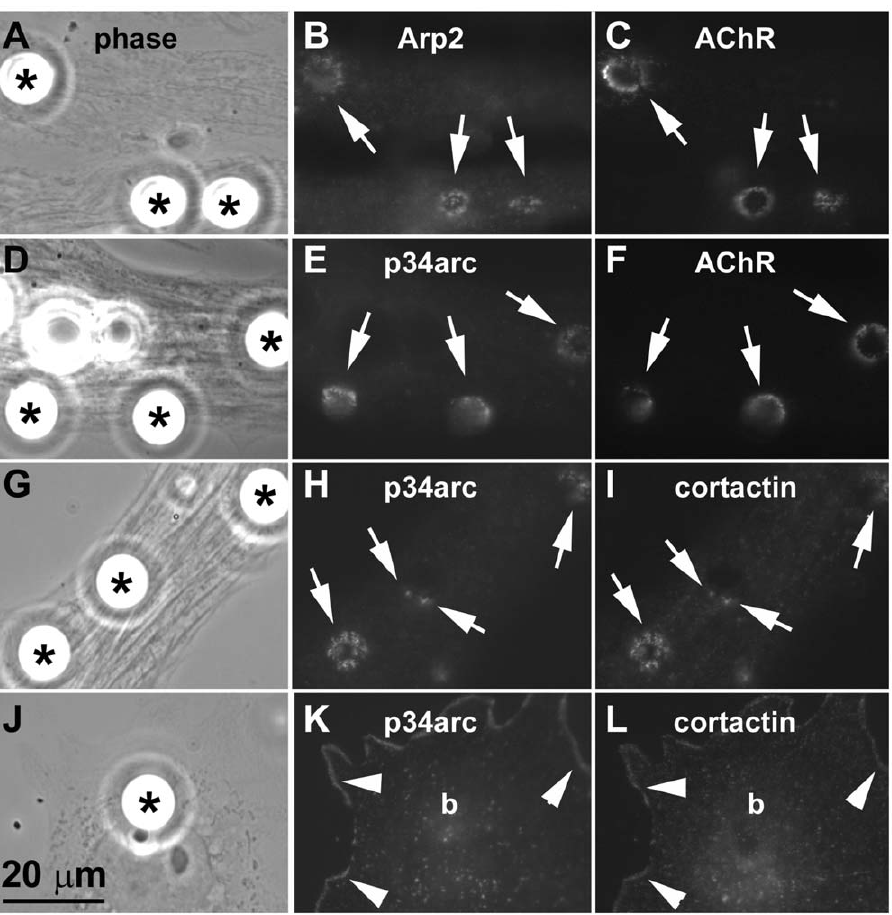
Figure 1. Localization of Arp2/3 complex proteins and cortactin at AChR clustering sites. Cultured embryonic Xenopus muscle cells labeled with rhodamine- a -bungarotoxin (R-BTX) were stimulated overnight with polystyrene beads coated with heparan-binding growth-associated molecule (HB-GAM) (A, D; asterisks) to induce AChR clusters (C, F). Cells were then fixed and labeled with affinity-purified polyclonal antibodies against the Arp2/3 complex proteins Arp2 (B) and p34arc (E) followed by FITC-linked anti-rabbit secondary antibodies. Separately, bead-stimulated muscle cells (G) were labeled with anti-p34arc polyclonal (H) and anti-cortactin monoclonal (I; mAb4F11) antibodies and then FITC-conjugated anti- rabbit and rhodamine-conjugated anti-mouse secondary antibodies. AChRs, Arp2 and p34arc were clustered at bead-muscle contacts (A-F; arrows) where cortactin localized and overlapped in distribution with p34arc (H and I; arrows). In primary muscle cultures non-muscle cells were occasionally found (J) and in these cells p34arc (K) and cortactin (L) localized along the cell periphery (arrowheads) but were not clustered at bead-cell contacts (‘‘b’’ in K and L corresponds to bead indicated by asterisk in J).